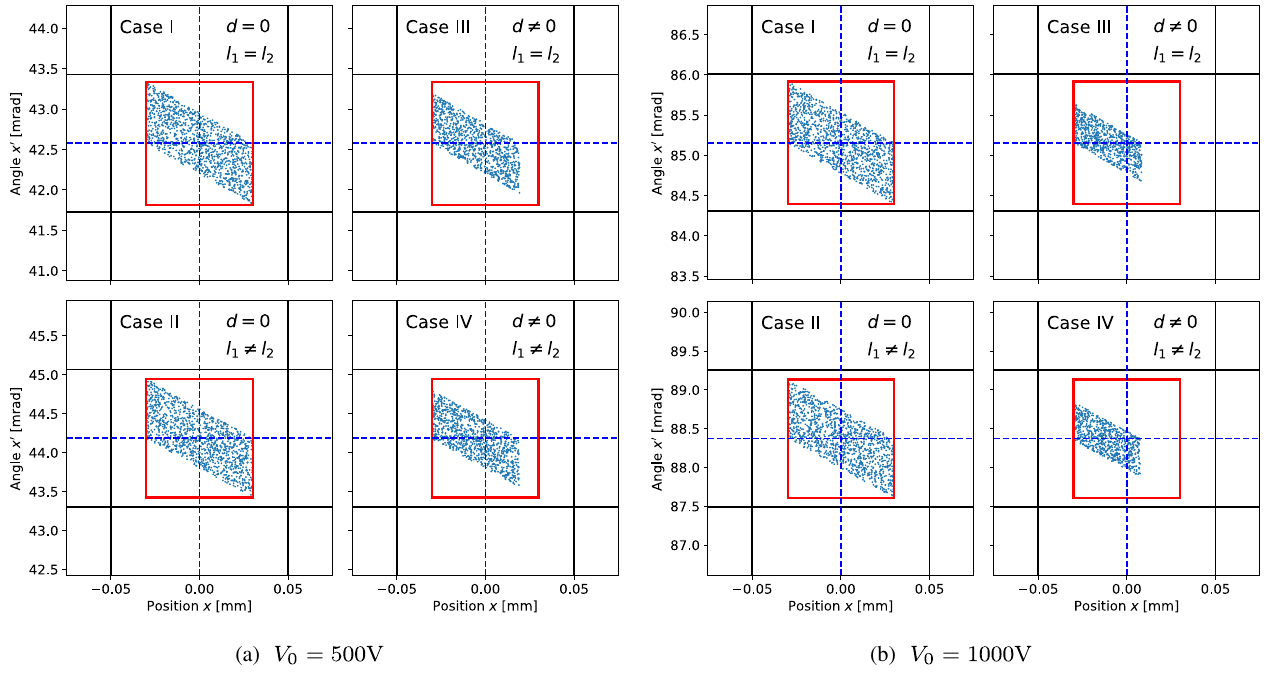
FIG. 3. Blue dots denote particles that are transmitted in the simulations described in Sec. II B 1. They map x - x 0 phase space regions at the device entrance z ¼ z that contribute to the data point at x ¼ 0 mm. Results are shown for all four geometric cases in Fig. 2 for i (a) V 0 ¼ 500 V and (b) V 0 ¼ 1000 V respectively. Geometric parameters for each case are listed in Table I. Black lines define the phase space grid with increments determined by the scanning step sizes.Dashed blue lines indicate the nominal position x ¼ 0 and angle x 0 ¼ x 0 corresponding to the data point. The red rectangles denote the device resolution predicted by the conventional treatment (i.e., Case I).